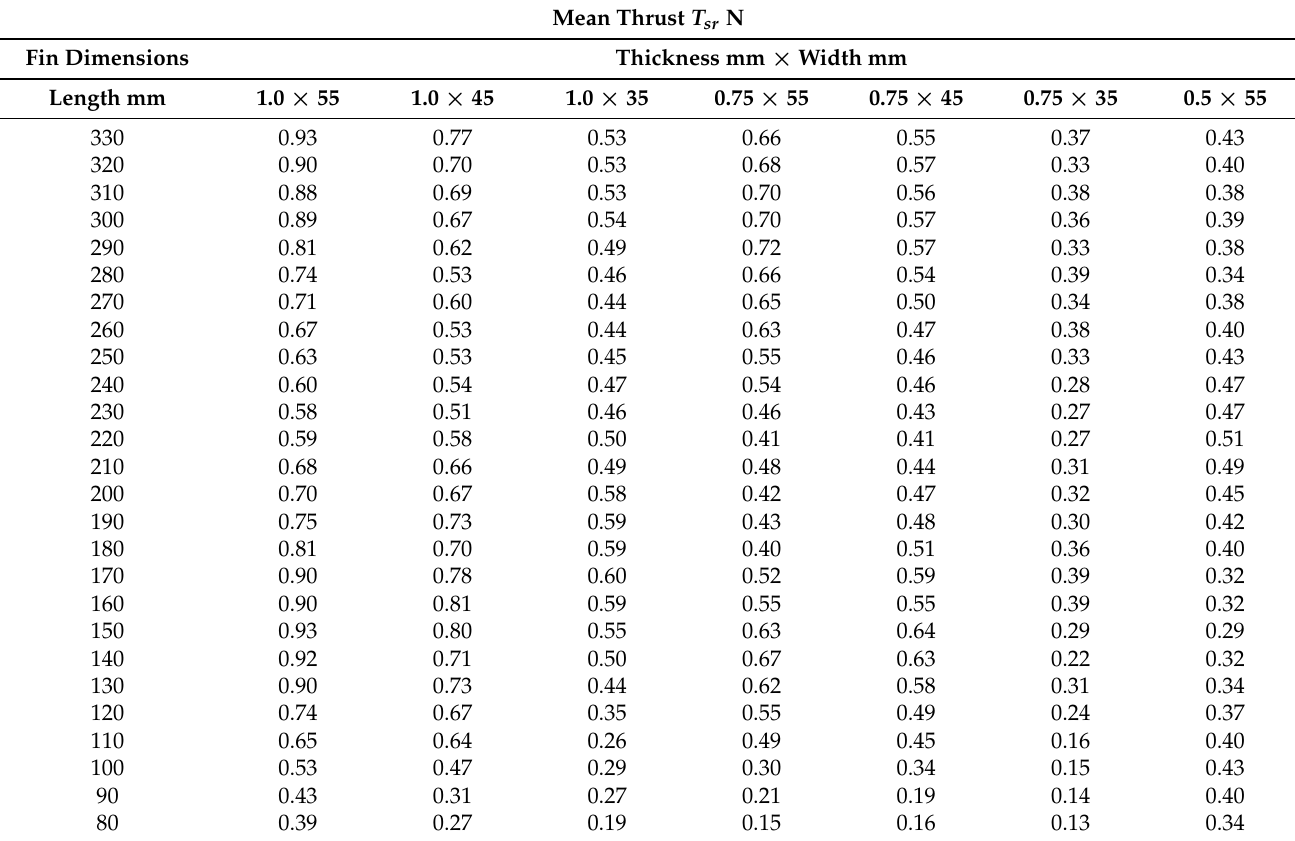
Table 1. Thrust mean results ( T sr ) measured for different fin